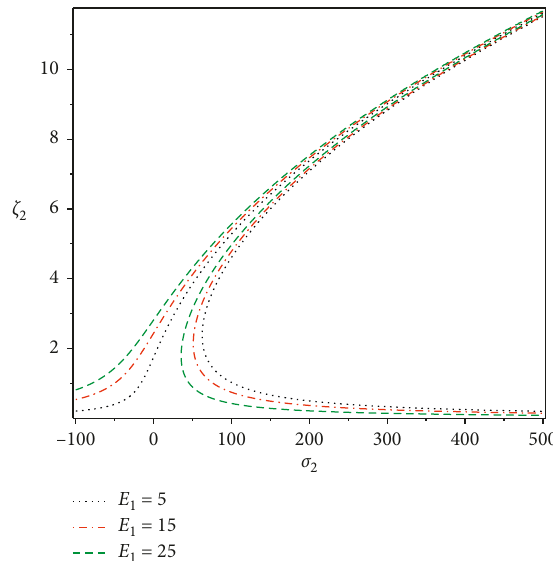
Figure 9: Frequency-response curves in the z direction with the electric